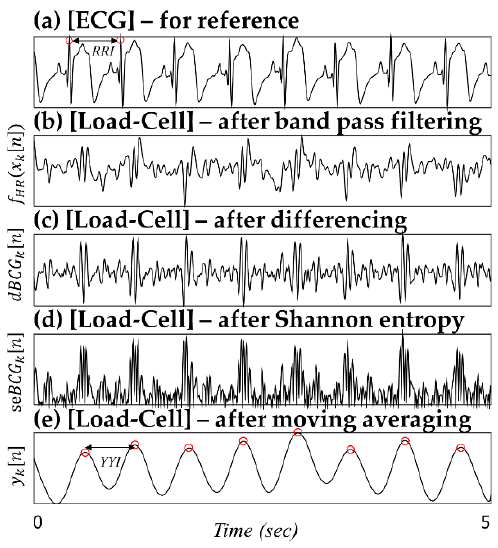
Figure 5. Pre-processing steps for the HR analysis.